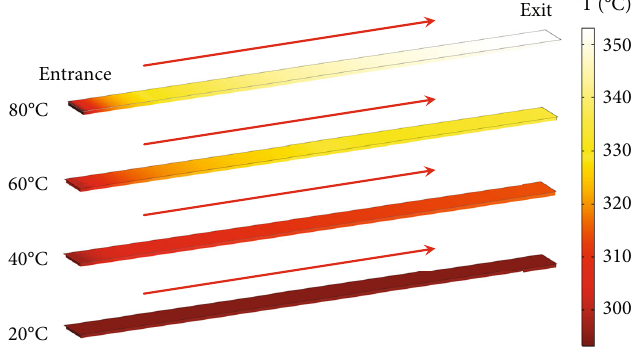
Figure 10: Temperature distribution at the time of the grouting completion for the 75 m fracture.